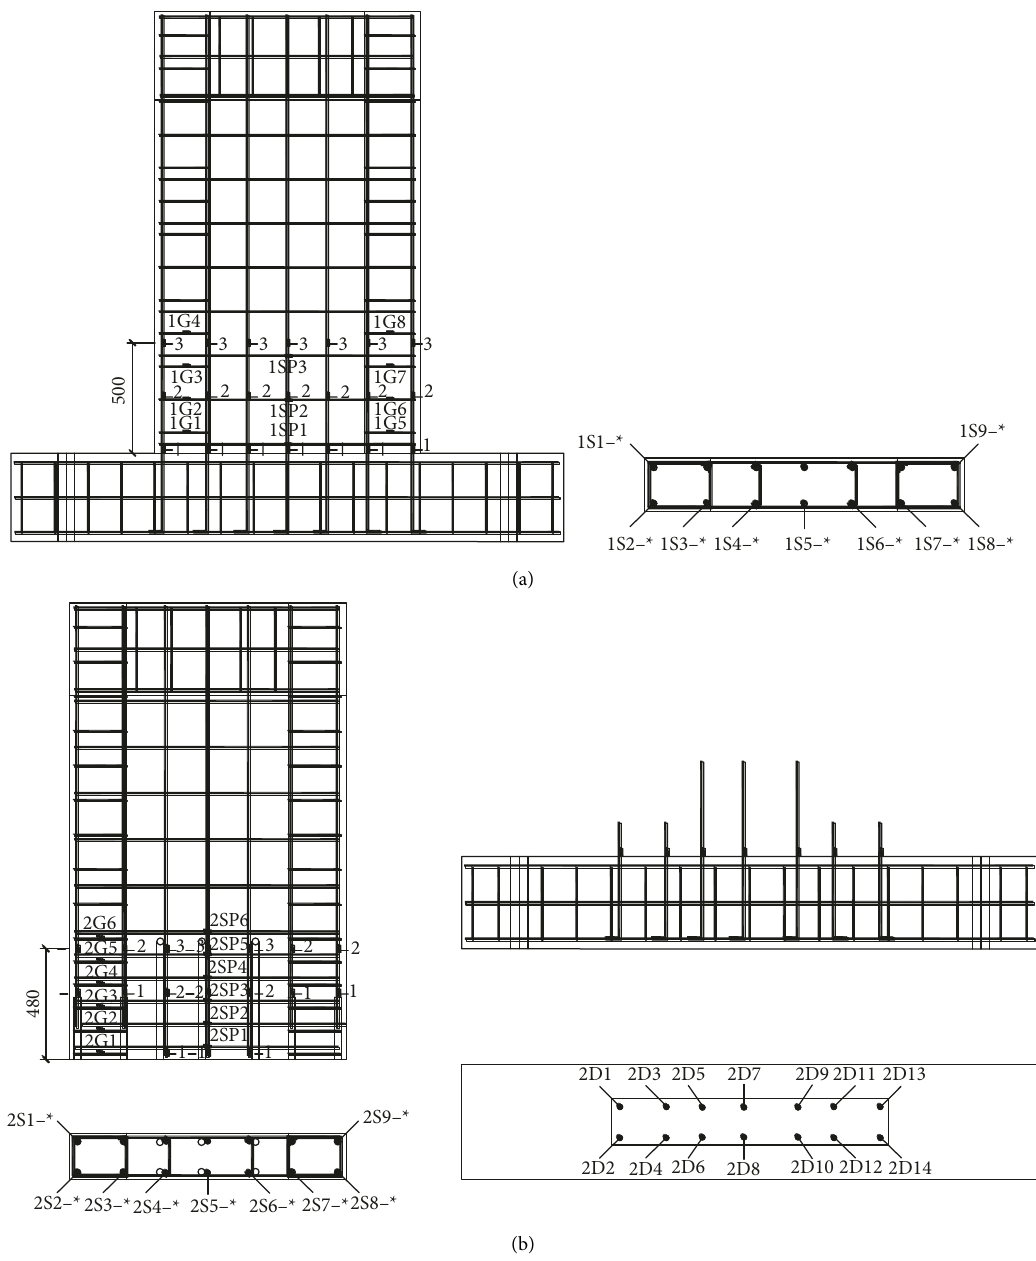
Figure 5: Strain gauge arrangements on specimens of (a) XJ and (b)